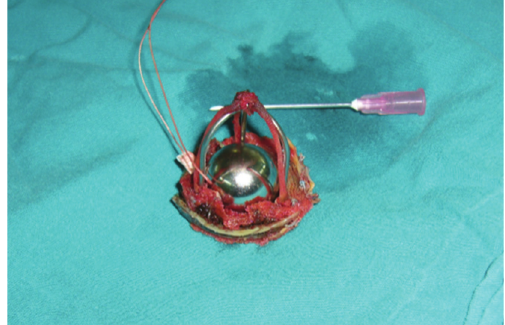
Figure 2: Significant cloth wear and dislodgement and bare cage metal of the excised caged ball